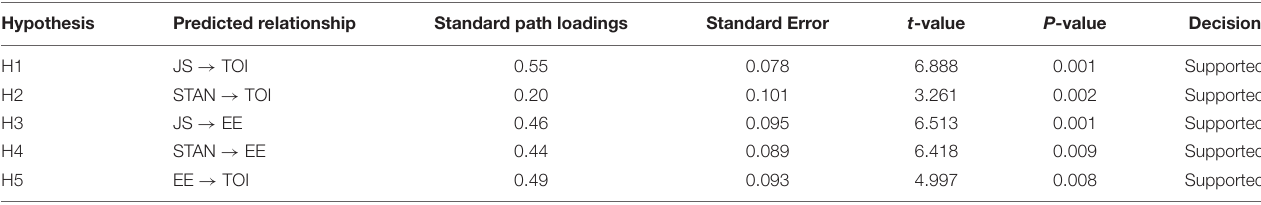
TABLE 5 | Regression results of the structural model and hypotheses test outcomes. Hypothesis